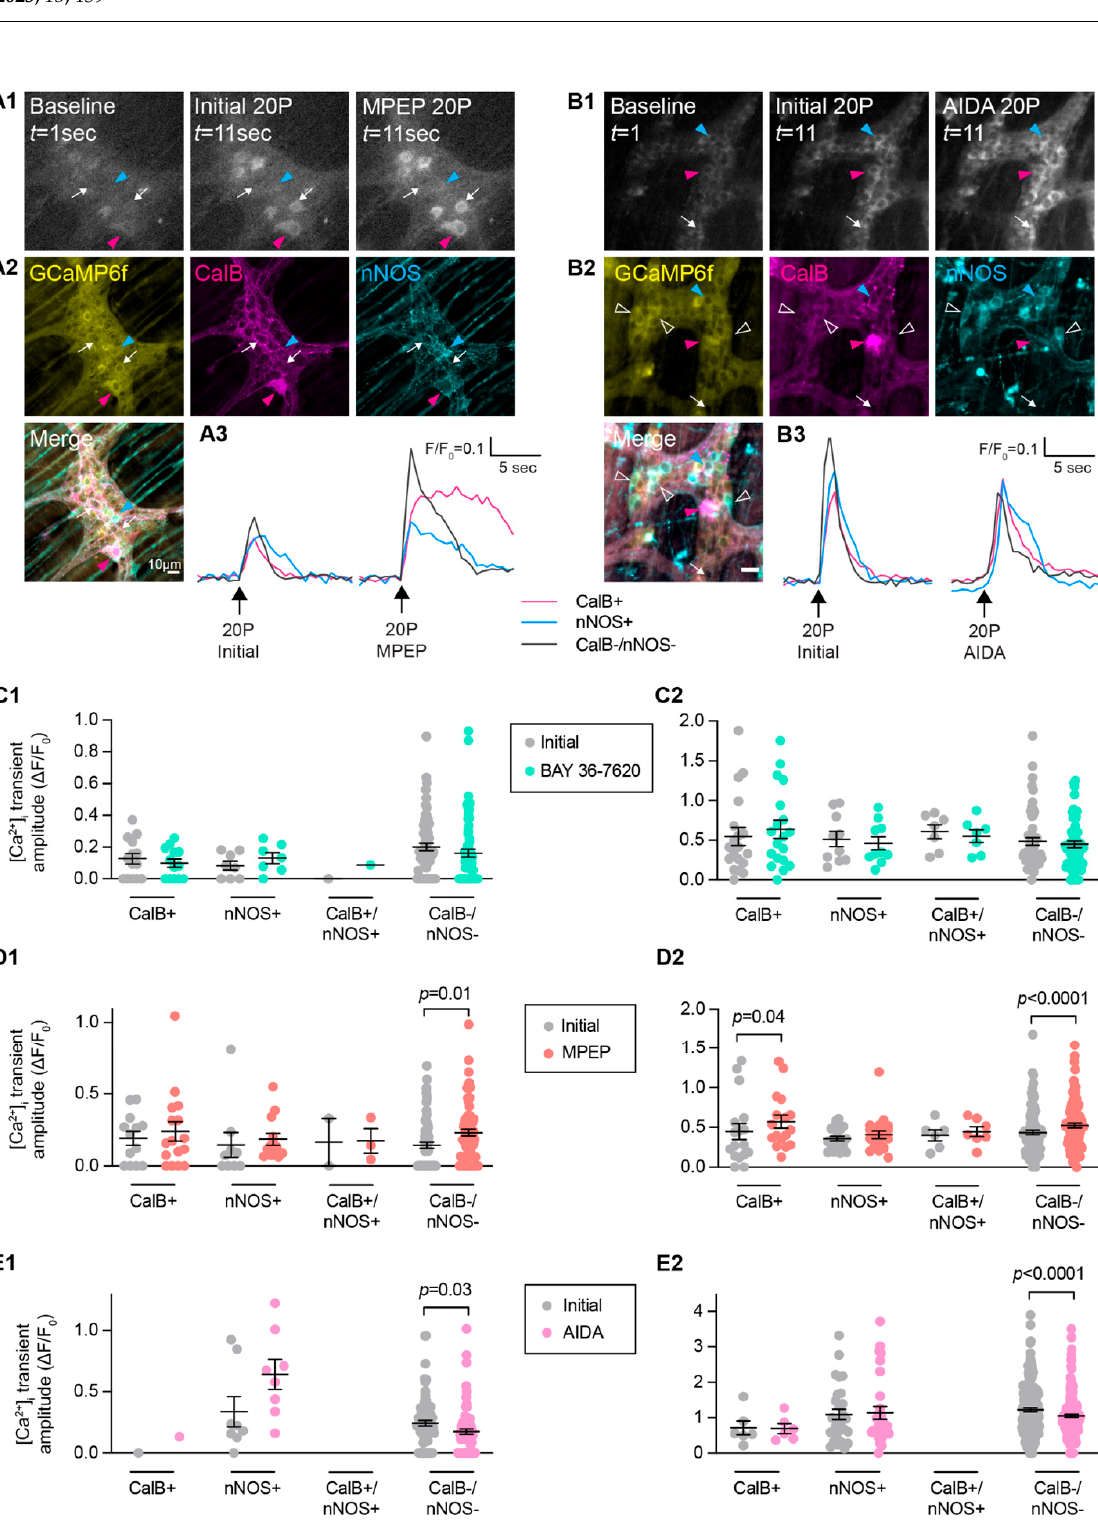
Figure 5. Effect of Group-I mGlu receptor antagonists in different neuronal subtypes. ( A1 , B1 ) Representative images of GCaMP6f fluorescence during live Ca 2+ recording of a myenteric ganglion at baseline (left, t = 1 s) after single (20P) stimulation of an interganglionic fiber tract in the presence of control Krebs’ solution (Initial, middle, t = 11 s) and after antagonist application (right, t = 11 s). ( A2 , B2 ) Post-hoc immunofluorescence staining of the same ganglion for GCaMP6f (yellow), Calbindin (CalB, magenta), and nNOS (cyan). Responsive neurons were found to be CalB+ (magenta triangle), nNOS+ (cyan triangle), or CalB − /nNOS − (white arrow) ( A3 , B3 ). Representative traces from a CalB+ neuron (magenta), nNOS+ neuron (blue), and CalB − /nNOS − neuron (dark grey) responding to 20P stimulation